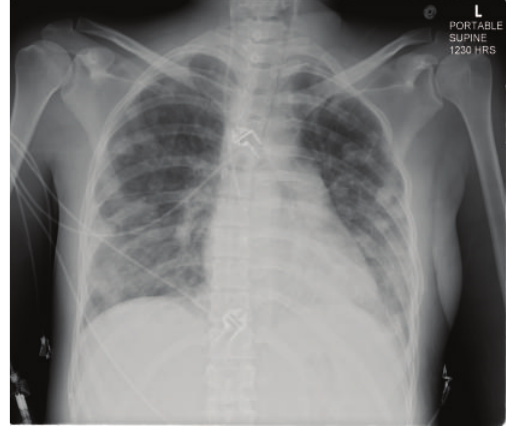
Figure 2: Chest X-ray showing pulmonary septic emboli.